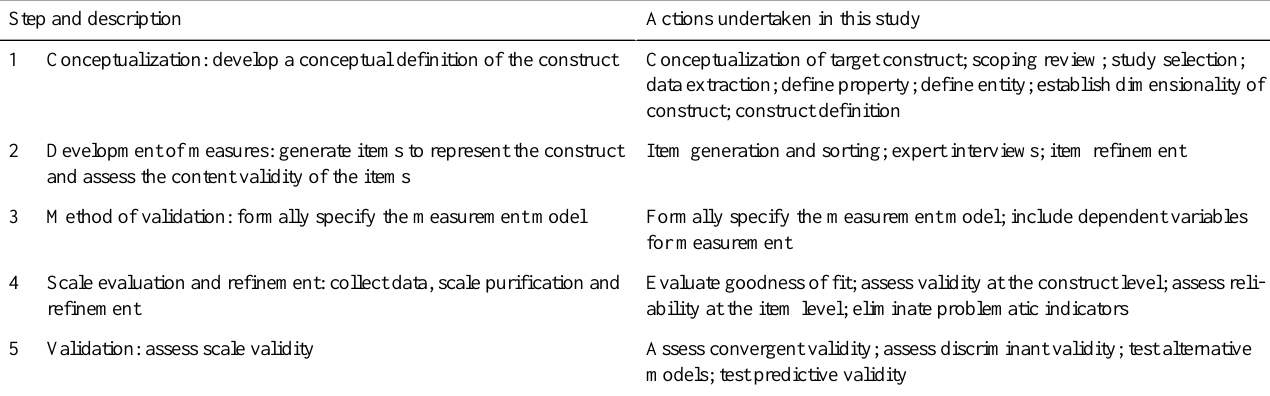
Table 1. Overview of scale development